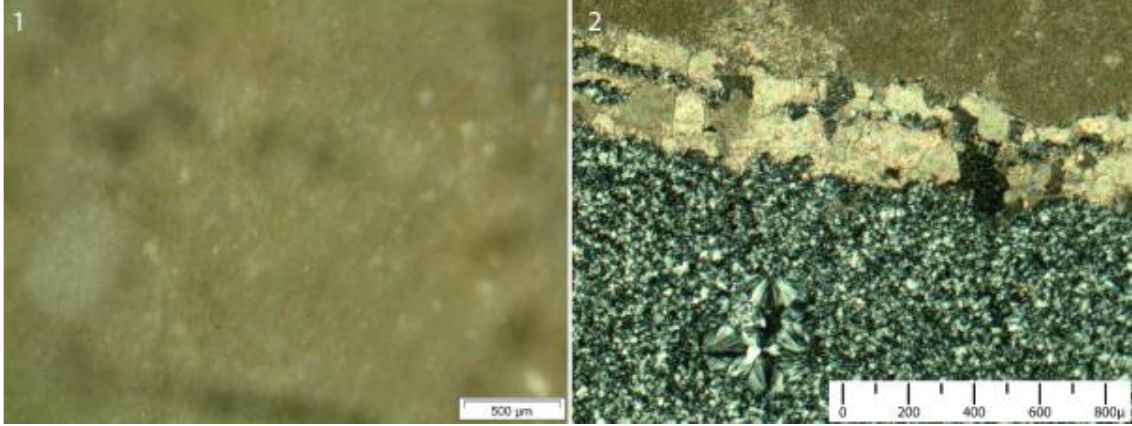
Figure 4. Oxfordian flints’ macro and microscopic textures and constituents; Type J3-2: 1. General texture (mudstone) (scale bar = 500 µm); 2. Spar calcite undergoing silicification at the contact between the silica matrix and the limestone (scale bar = 800